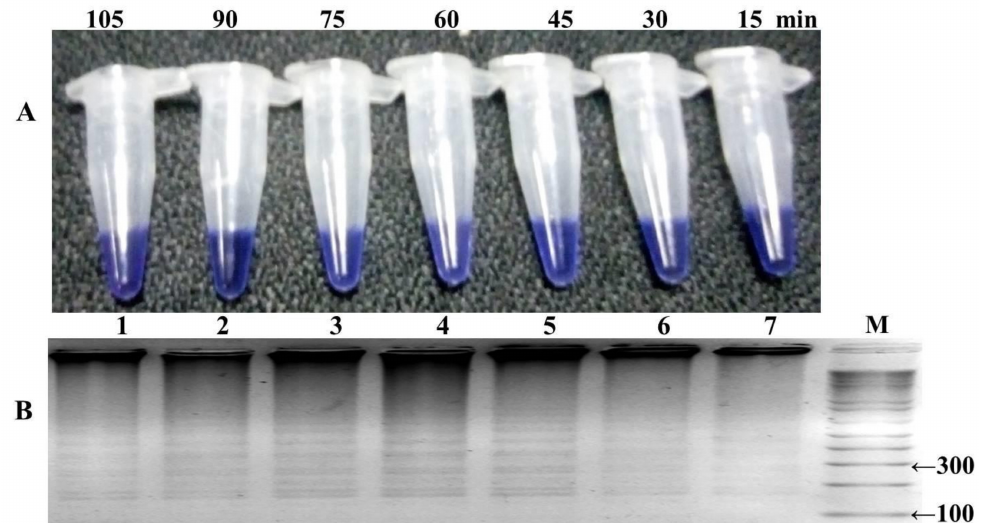
Figure 5. Optimization of the HNB–LAMP reaction at time intervals. ( A ) Assessment was based on HNB color change visualization. A positive reaction started to color change from violet to blue after 45 min at 60–66 ◦ C, indicated by tube no. 5. ( B ) Validation through gel electrophoresis at di ff erent time intervals: M-100 bp ladder, lanes 1 to 7 showed a time range from 15 to 105 min, and the maximum amplification of the LAMP product in a short time was observed at 45 min (lane 5) as compared to the amplification e ffi ciency within 30 and 15 min indicated in lanes 6 and